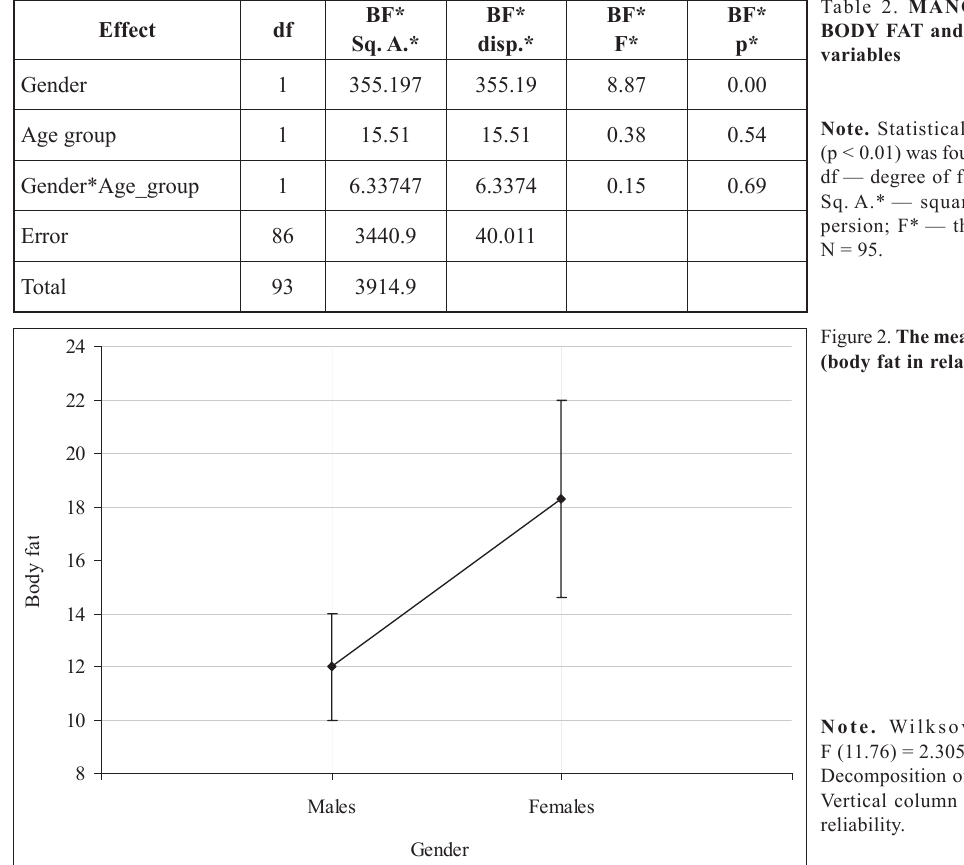
Table 2. MANOVA result — domain BODY FAT and interaction between the variables